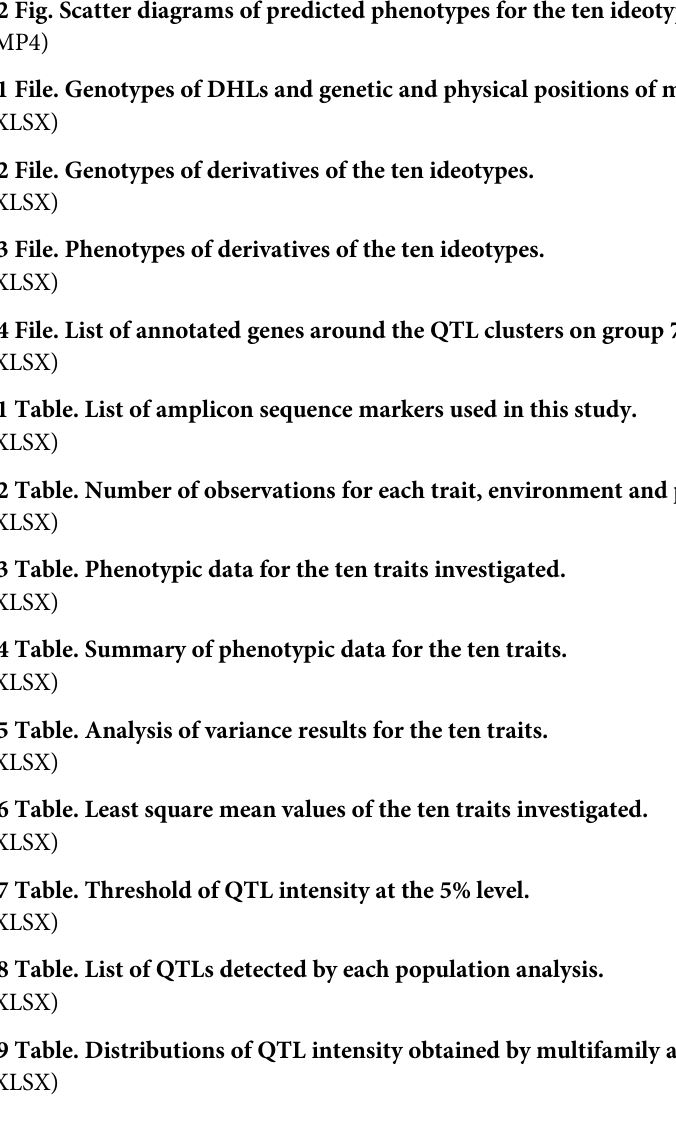
S1 Fig. Distributions of x50, Sm, FPC and Fash for the three populations. S2 Fig. Scatter diagrams of predicted phenotypes for the ten ideotypes. (MP4) S1 File. Genotypes of DHLs and genetic and physical positions of markers.